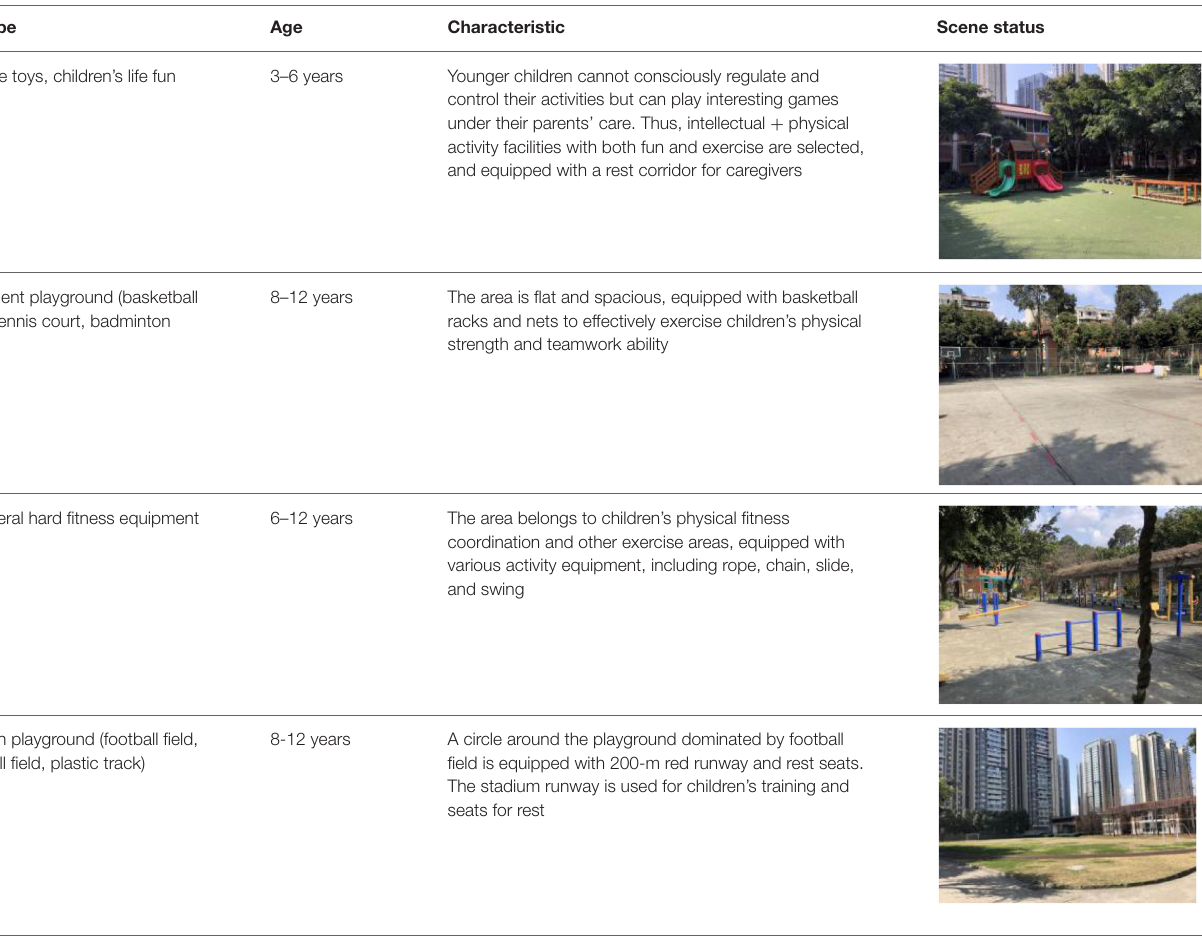
TABLE 6 | Space classification of several important outdoor activities in the SOS children’s